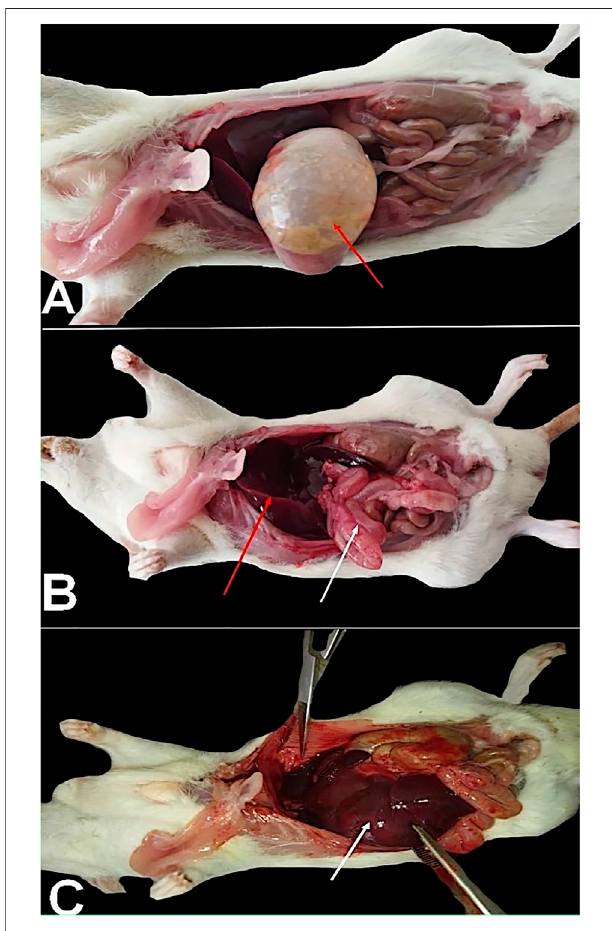
FIGURE 4 | Rats exposed to SiNP5 exhibited a gas- fi lled intestine [ (A) , red arrow], and the rats exposed to SiNP10 showed a congested liver (B, red arrow), an in fl ated intestine with in fl ammation [ (B) , white arrow]. Through exposure to SiNP20, rats demonstrated severe congested liver [ (C) , white arrow] and petechial hemorrhage on the intestine.